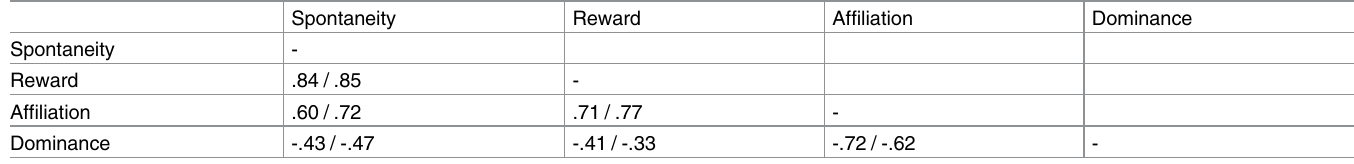
Table 3. Pearson’s correlation coefficients for the judgment dimensions, based on each laugh’s averagerating (female actors / male actors).